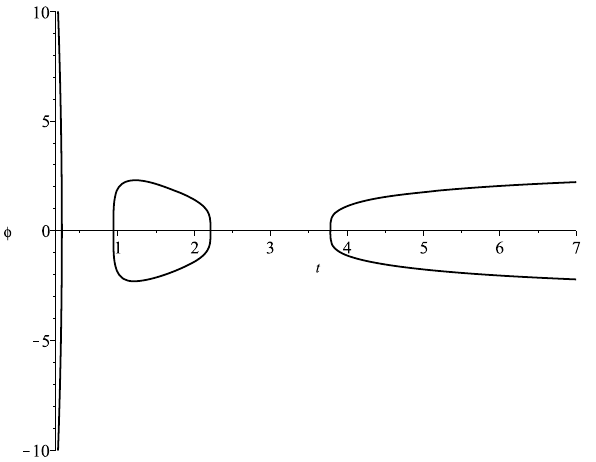
Fig. 5 Evolution of scalar field for Higgs potential for ˜ λ = − 1, m = 1 . 8. Zeros of the T ( 1 / t ) are 0.263, 0.941, 2.213, 3.783